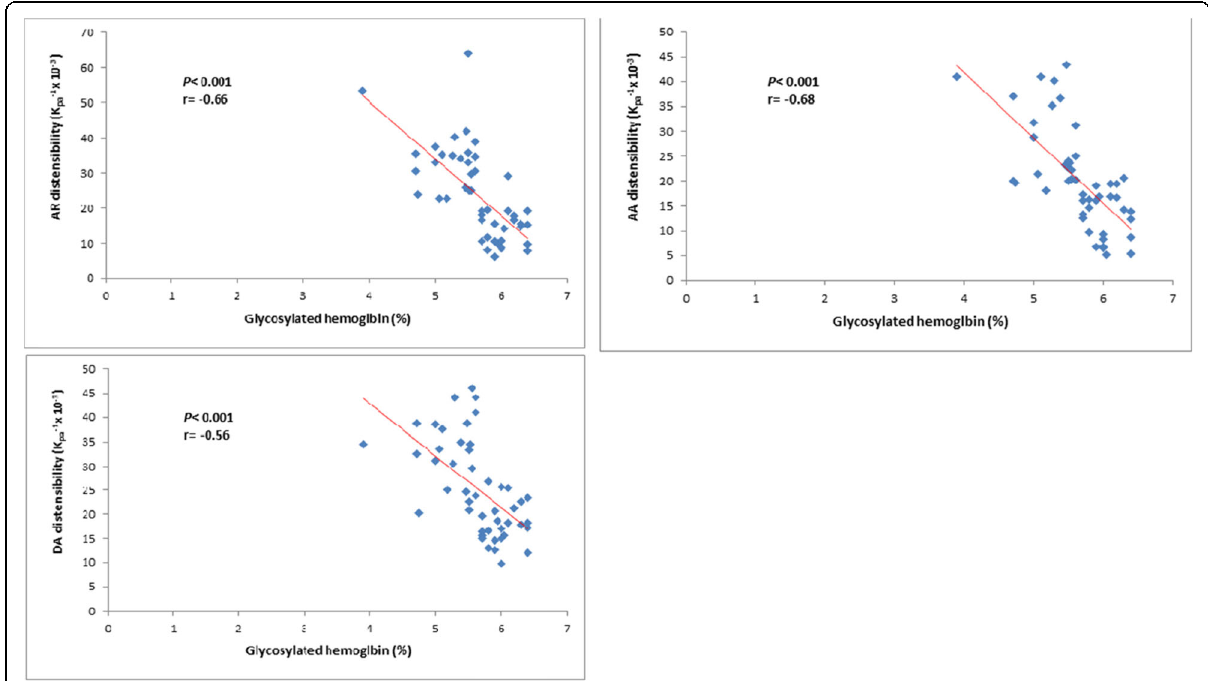
Fig. 2 Correlation between Hba1C and aortic distensibility at different levels